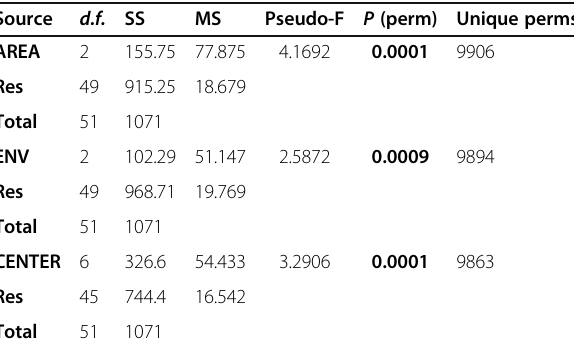
Table 3 Output of the main PERMANOVA tests for water column variables. Factors of analysis were channel area